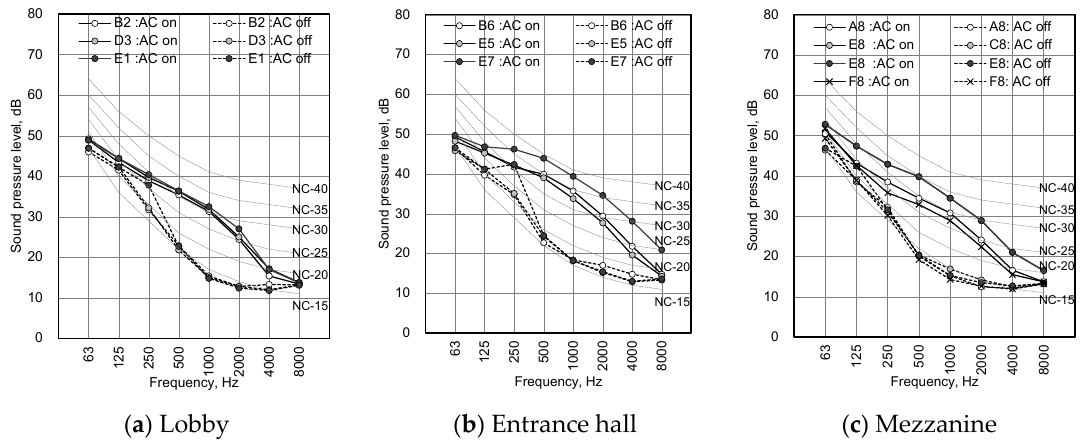
Figure 8. Frequency characteristic of the sound pressure level of indoor noise in ( a ) the lobby, ( b ) entrance hall, and ( c ) mezzanine. AC means air-conditioning.